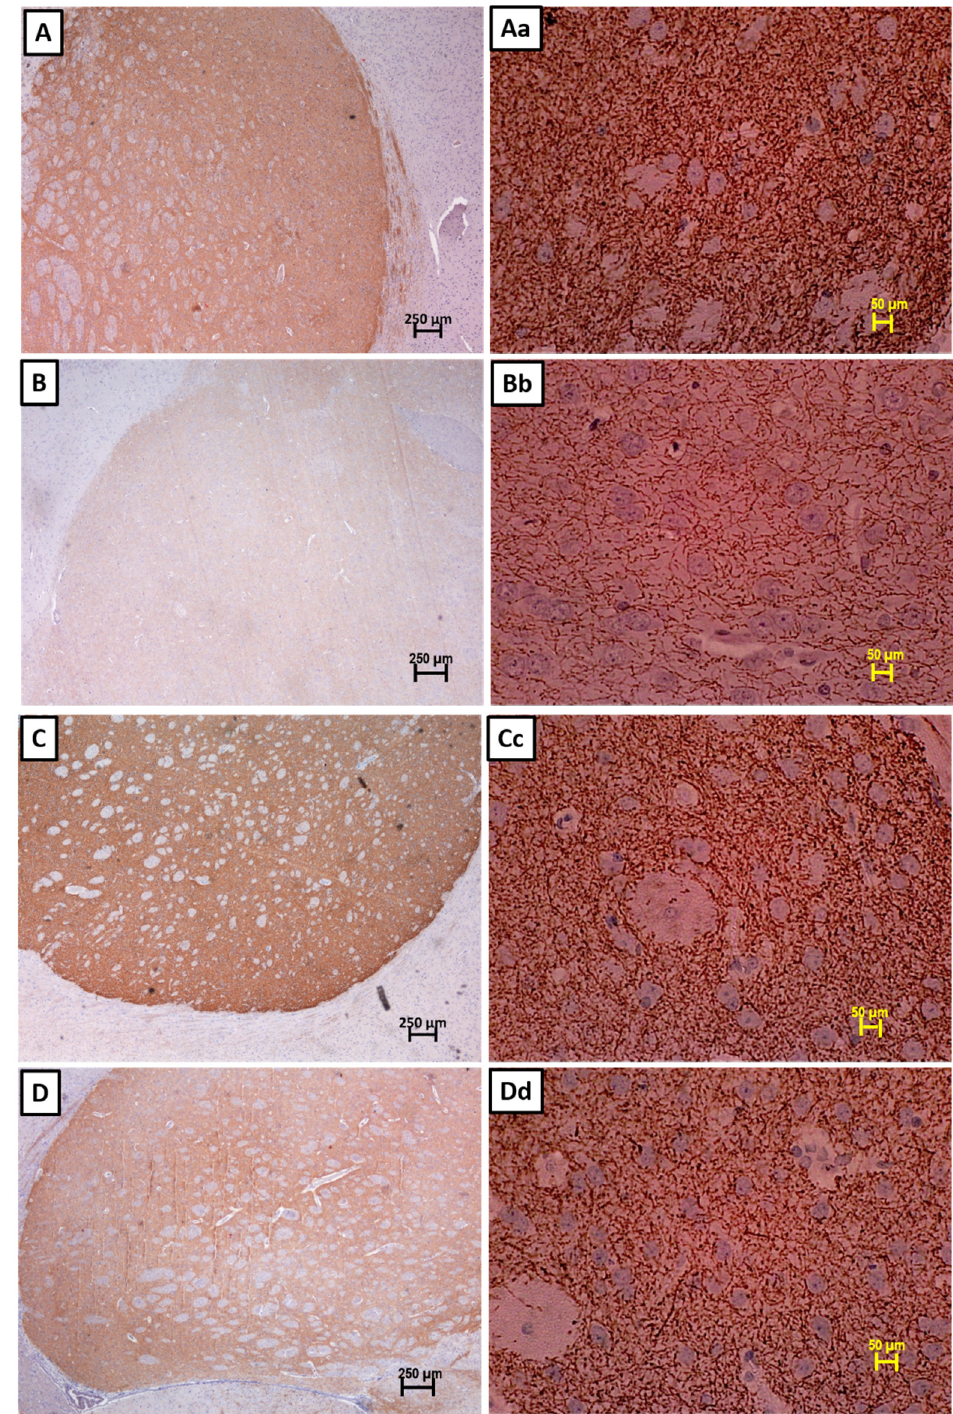
Figure 6. Photomicrographs of tyrosine hydroxylase (TH)-immunostained coronal sections of striatum (STR) from the ( A ) control group showing intense staining and dense fibres, ( B ) 250 µg 6-OHDA-injected group showing weak staining and reduced fibre density due to dopaminergic striatal fibre loss, ( C ) 250 µg 6-OHDA + α -T3-treated group, and ( D ) 250 µg 6-OHDA + γ -T3-treated group showing intense staining and dense fibres due to rescue of DA fibres by both isomers of T3. (Left half ( A – D ) lower magnification, Scale bar: 250 µm; Right half ( Aa – Dd ) higher magnification, Scale bar: 50 µm).